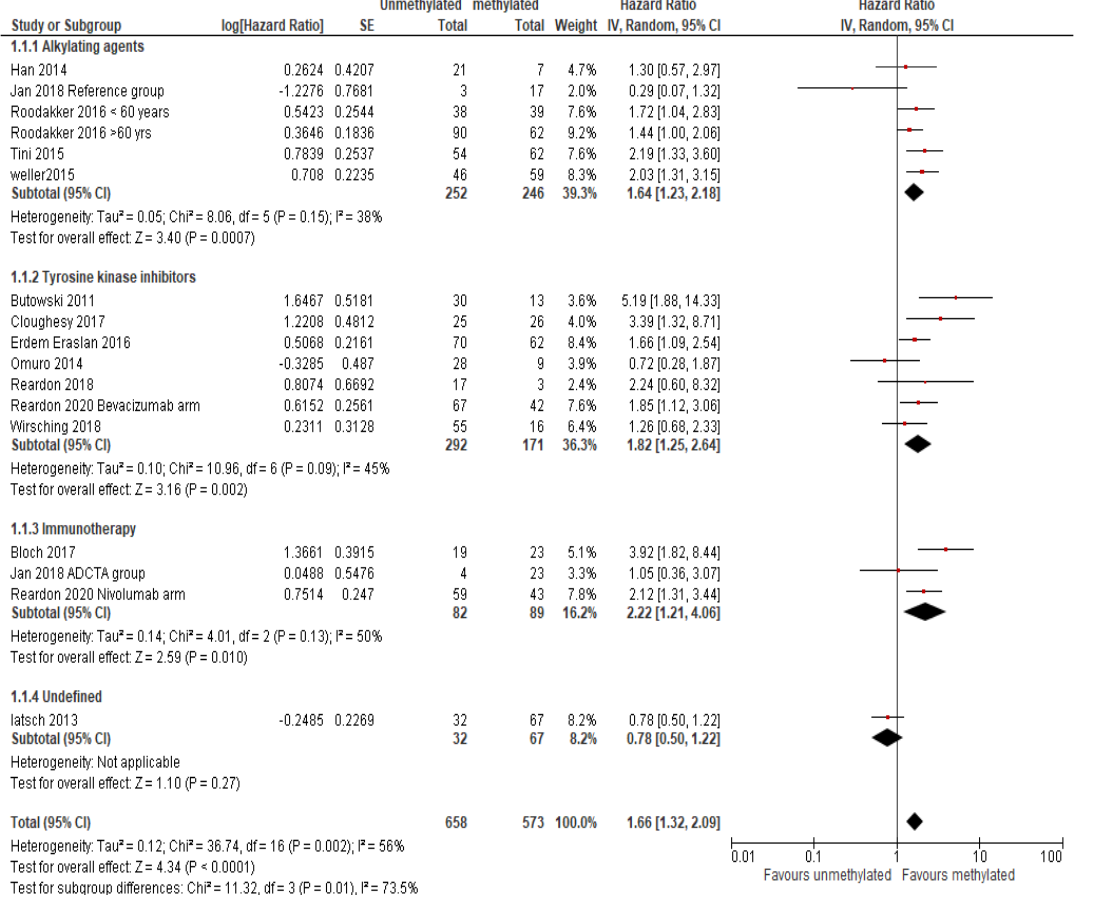
Figure 2. A forest plot demonstrating the association of MGMT methylation status with OS [15,25,26,28,30,33–35,38–40,42–44]. Abbreviations: SE: standard error; CI: confidence interval, ref=reference, bev= bevacizumab, niv= nivolumab < 60= < 60 years, > 60= >60 years. Size of the red square indicates the relative weight of the study as it contributes to the results of the overall comparison. The diamond at the bottom of the forest plot shows the result when all the individual studies are combined and averaged. The effect measure used was HR, where values greater than 1.0 indicate that patients with MGMT methylation has low risk of mortality than patients with unmethylated MGMT and vice versa for values less than